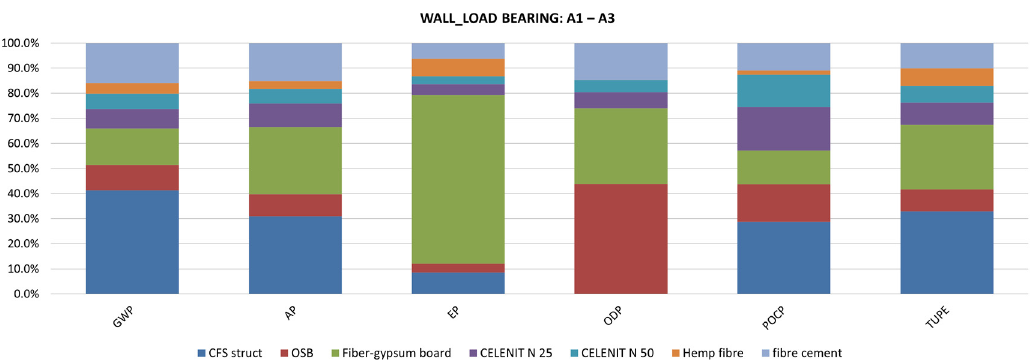
Figure 11. LCIA results: load-bearing walls. Table 12. Results of Life Cycle impact assessment: load-bearing walls.